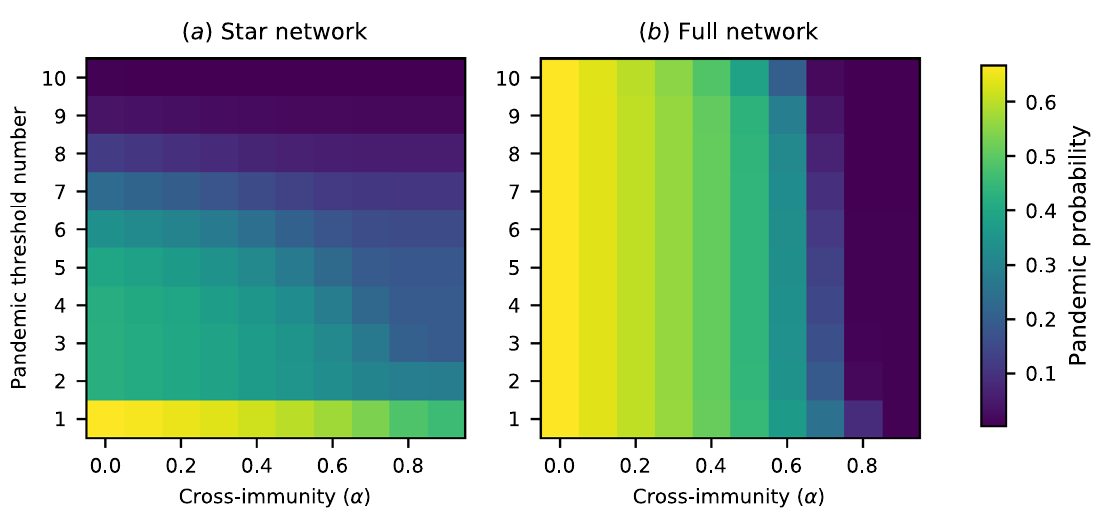
Figure 4. Plots of pandemic probability against travel rate for high and low levels of cross-immunity ( α ) on ten-region networks. A pandemic is defined here as all ten regions experiencing epidemics, i.e. the 10-region transregional definition. The plots show a large relative difference both in the probability of pandemics and in how that probability scales with travel rates for different levels of cross-immunity. The initial infected individual for each outbreak originates in a randomly chosen region. ( a ) Plot of pandemic probability for a star network. ( b ) Plot of pandemic probability for a full network.